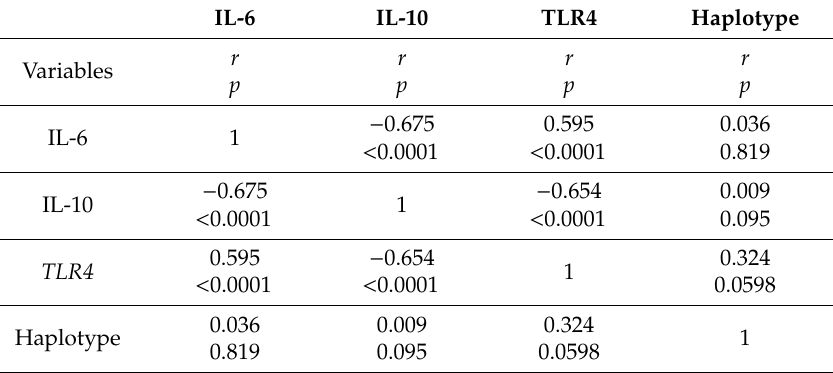
Table 6. Pearson coe ffi cient correlation (r) between haplotypes rs4986790 and rs4986791 and IL-6, IL-10 and CD284 of monocyte TLR4 among the cohort of study